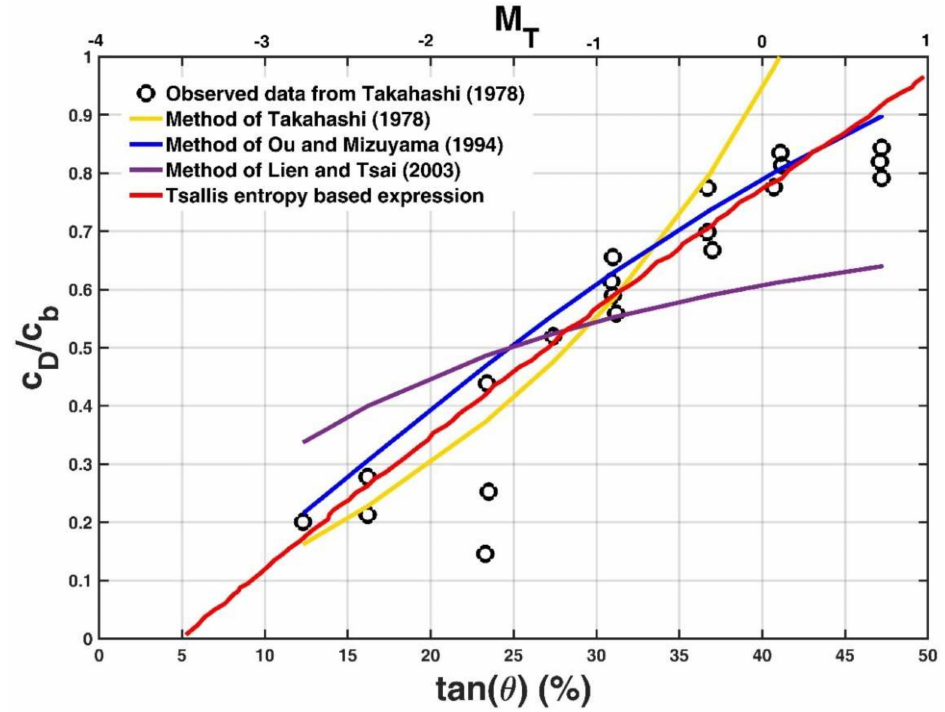
Figure 3. Comparison of the formulae of Takahashi [8] (Equation (5)), Ou and Mizuyama [19] (Equation (6)), and Lien and Tsai [12] (Equation (7)) and the Tsallis entropy-based expression (Equation (42)) with observed data from Takahashi [8]. Here, the general index entropy-based expression (Equation (23)), the Renyi entropy-based expression (Equation (36)), and the Shannon entropy-based expression (Equation (48)) are not shown because they did not fit the data points